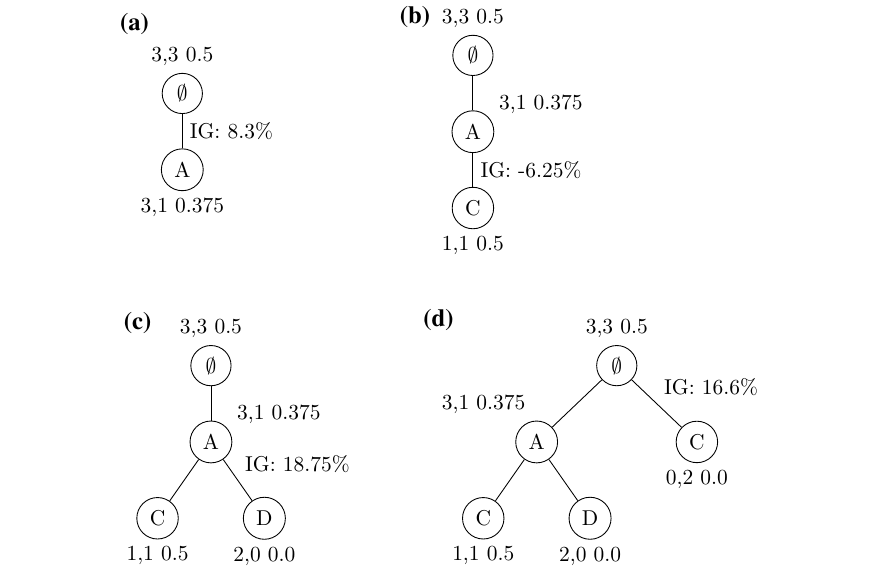
Fig. 3 CAP-growth. Here, the letters a – d refer to the order in which the figures must be read. Example visit of the CAP-tree in Fig.